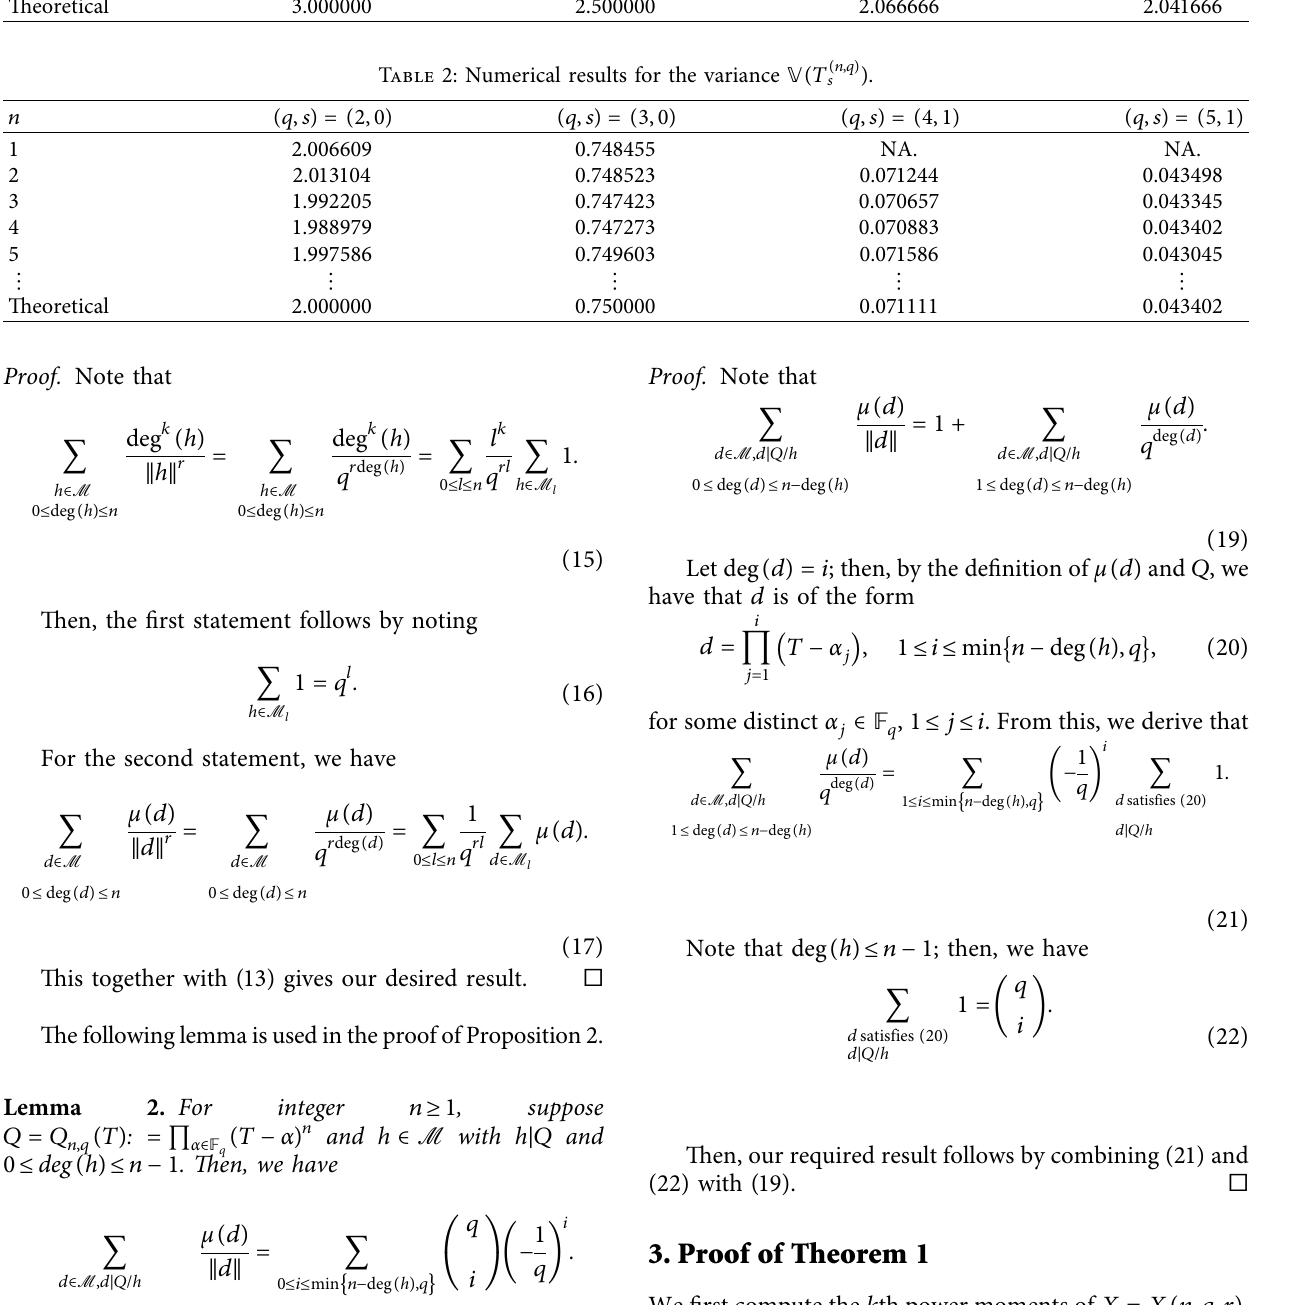
Table 1: Numerical results for the expectation E ( T ( n,q )